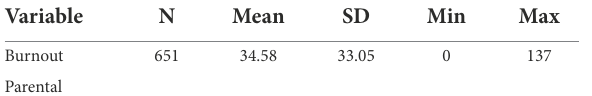
TABLE 1 Descriptive of PB for objective 1.